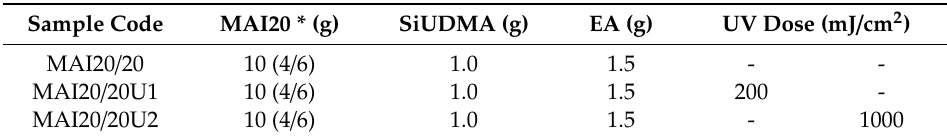
Table 2. Formulation of UV-cured SPSA composition.